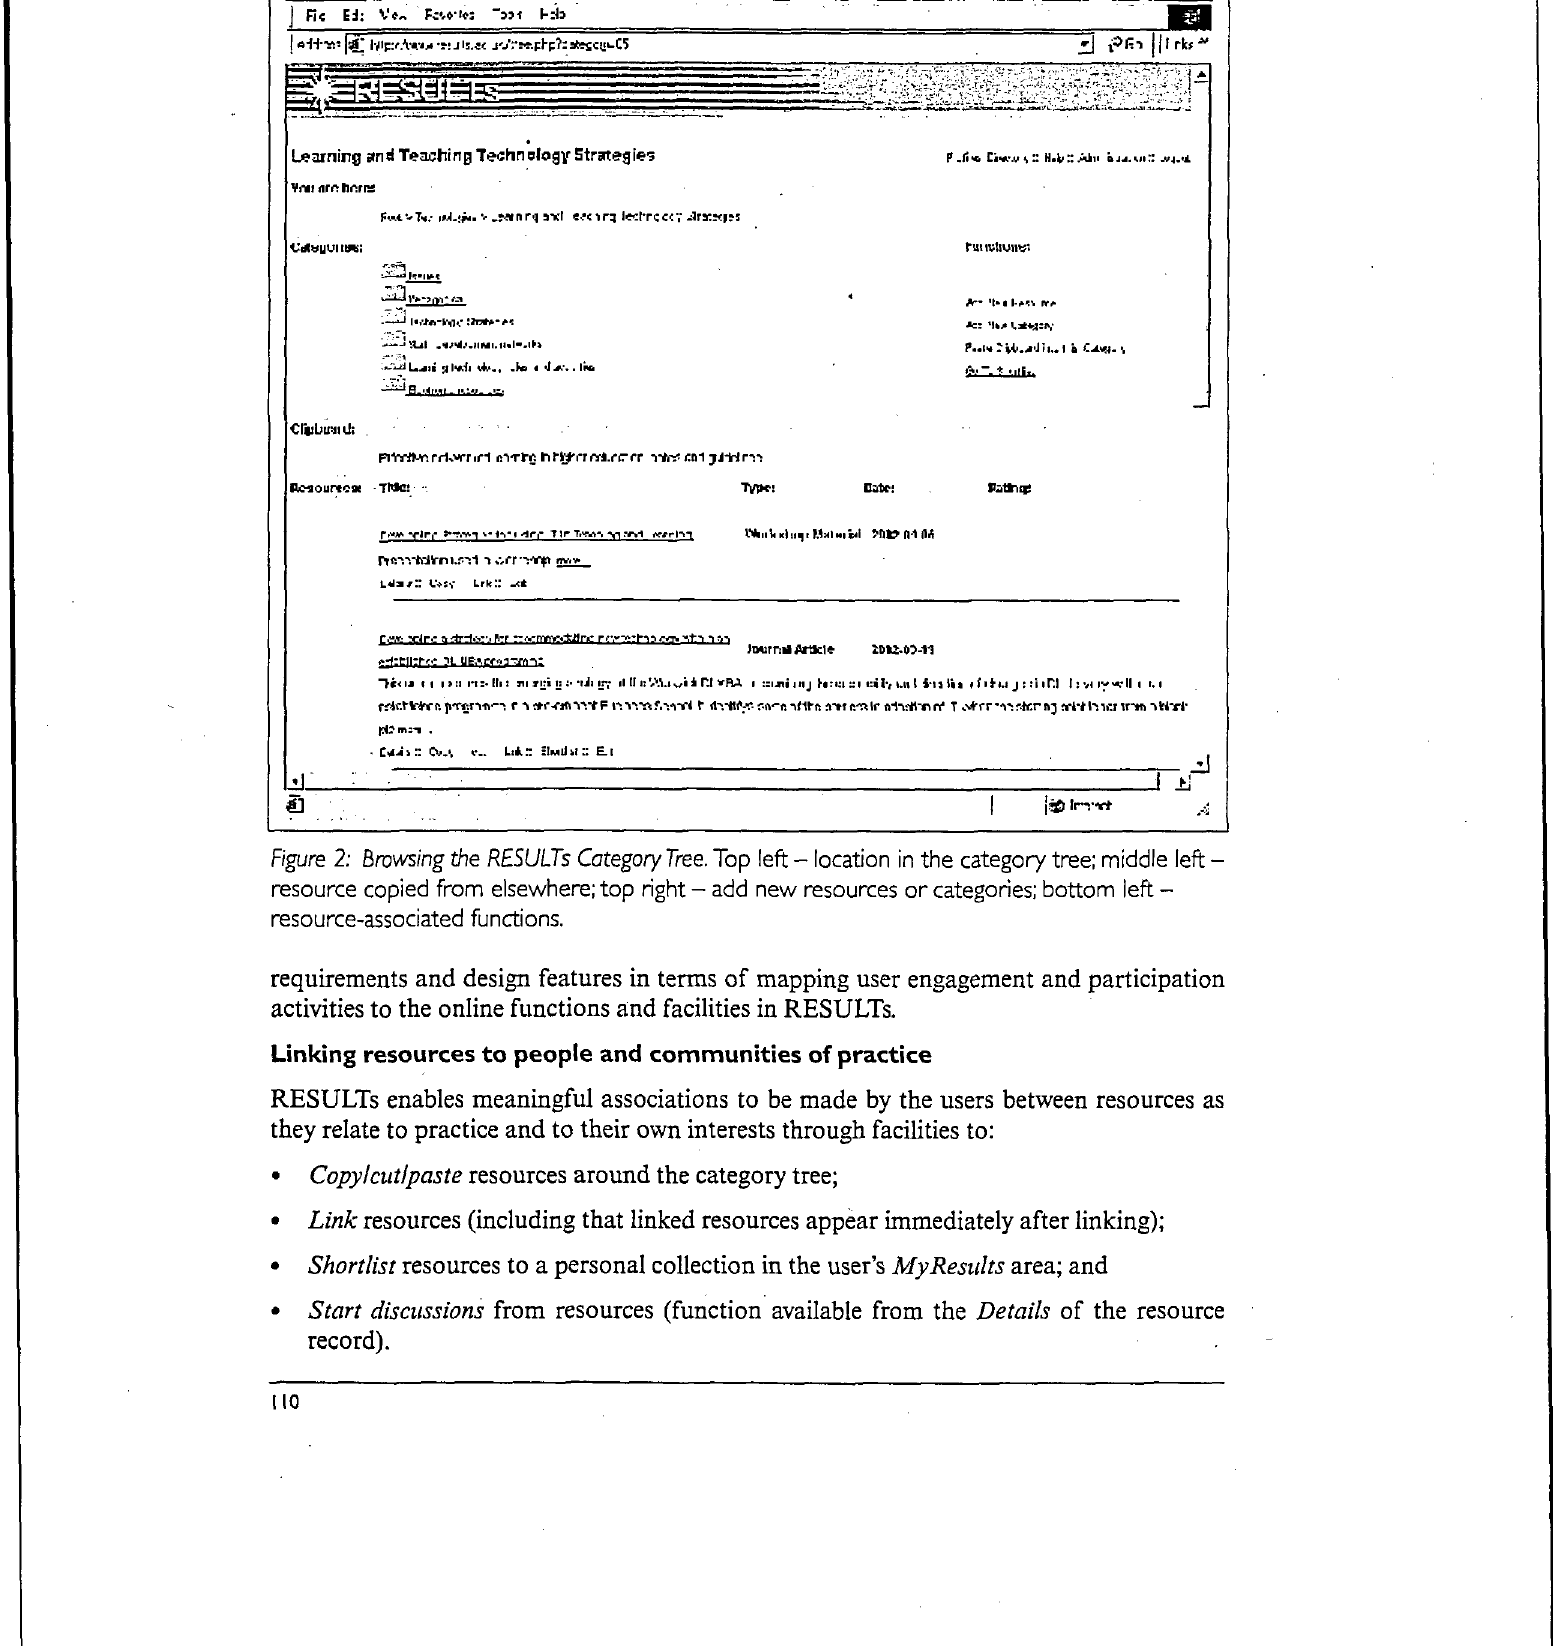
figure 2: Browsing the RESULTS Category Tree. Top left - location in the category tree; middle left - resource copied from elsewhere; top right - add new resources or categories; bottom left - resource-associated